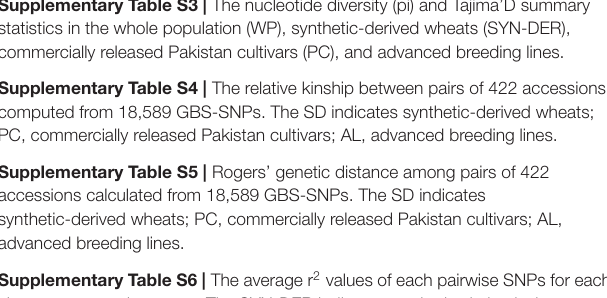
Supplementary Figure S4 | Gene ontology (GO) enrichment analysis for selected regions identified by EigenGWAS. Top 30 significantly enriched GO − log 10 (p) terms irrespective of biological processes, cellular components, and molecular functions. Supplementary Table S1 | Distribution of the 422 wheat accessions.